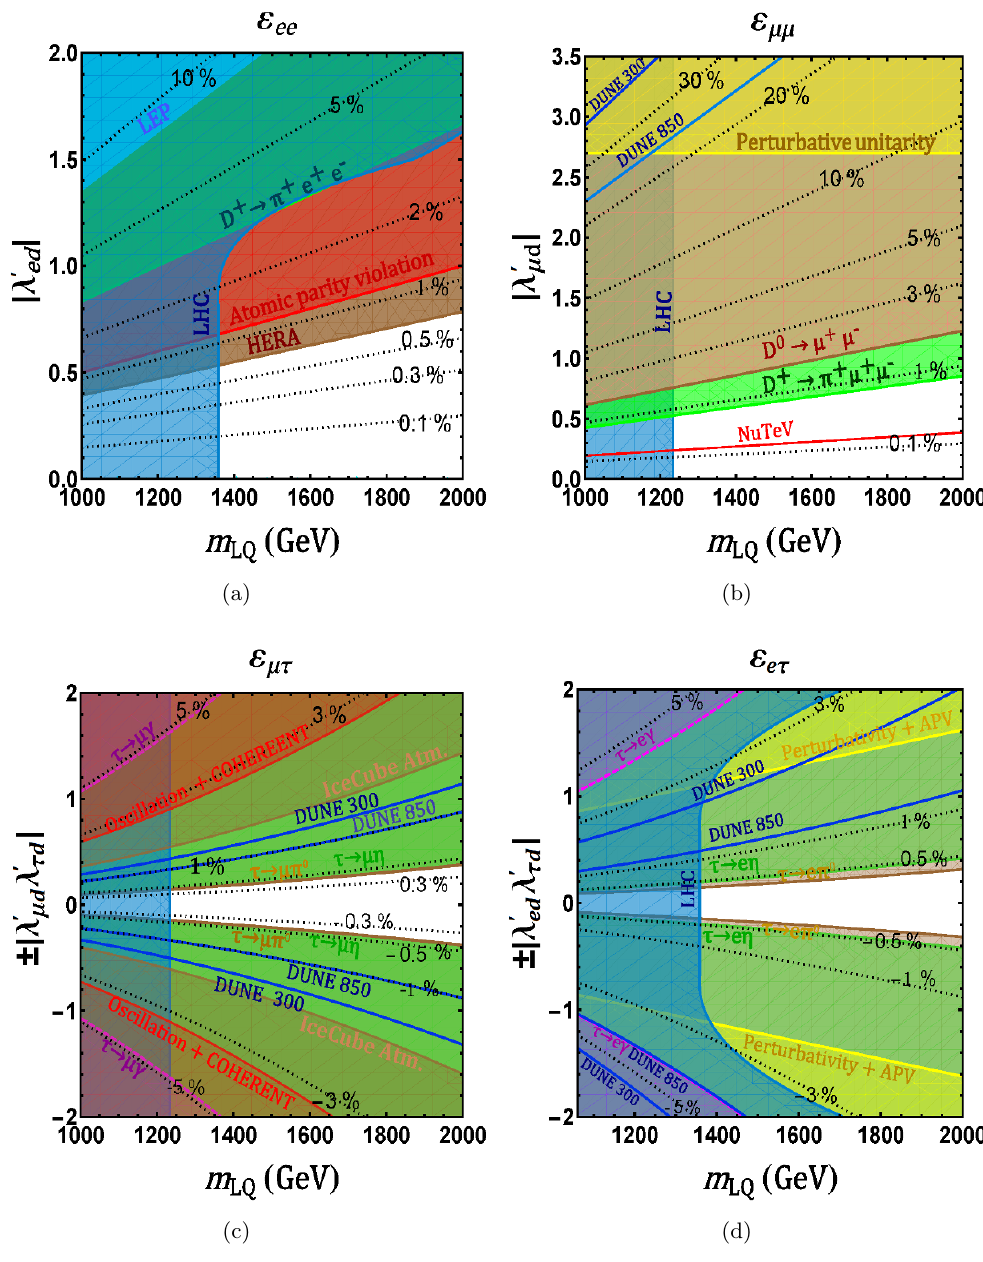
Figure 33 . Additional low-energy constraints on NSI induced by singlet LQ. Sub(cid:12)gure (a) has the same APV and LHC constraints as in (cid:12)gure 18(a), the modi(cid:12)ed HERA and LEP contact interaction bounds (cf. table 16), plus the D + (cid:25) + e + e (cid:0) constraint, shown by green-shaded region ! (cf. section 5.1.6). Sub(cid:12)gure (b) has the same constraints as in (cid:12)gure 18(b), plus the D + (cid:25) + (cid:22) + (cid:22) (cid:0) ! constraint, shown by light-green-shaded region, and D 0 (cid:22) + (cid:22) (cid:0) constraint shown by brown-shaded ! region (cf. section 5.1.6). Sub(cid:12)gure (c) has the same constraints as in (cid:12)gure 19(a), plus the (cid:28) (cid:22)(cid:13) ! constraint, shown by purple-shaded region. Sub(cid:12)gure (d) has the same constraints as in (cid:12)gure 19(b), plus the (cid:28) e(cid:13) constraint, shown by purple-shaded region. !